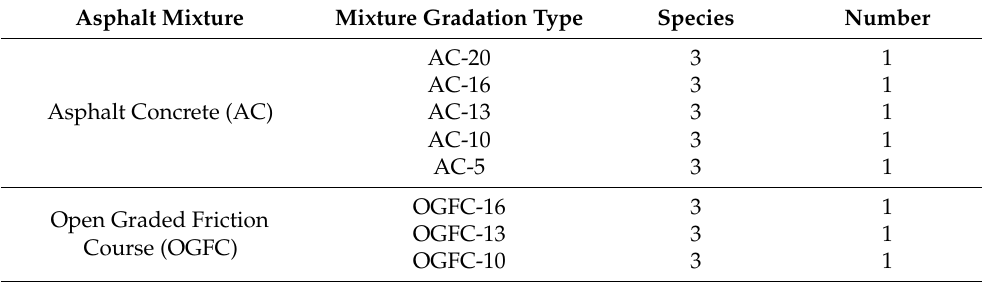
Table 1. Asphalt mixture